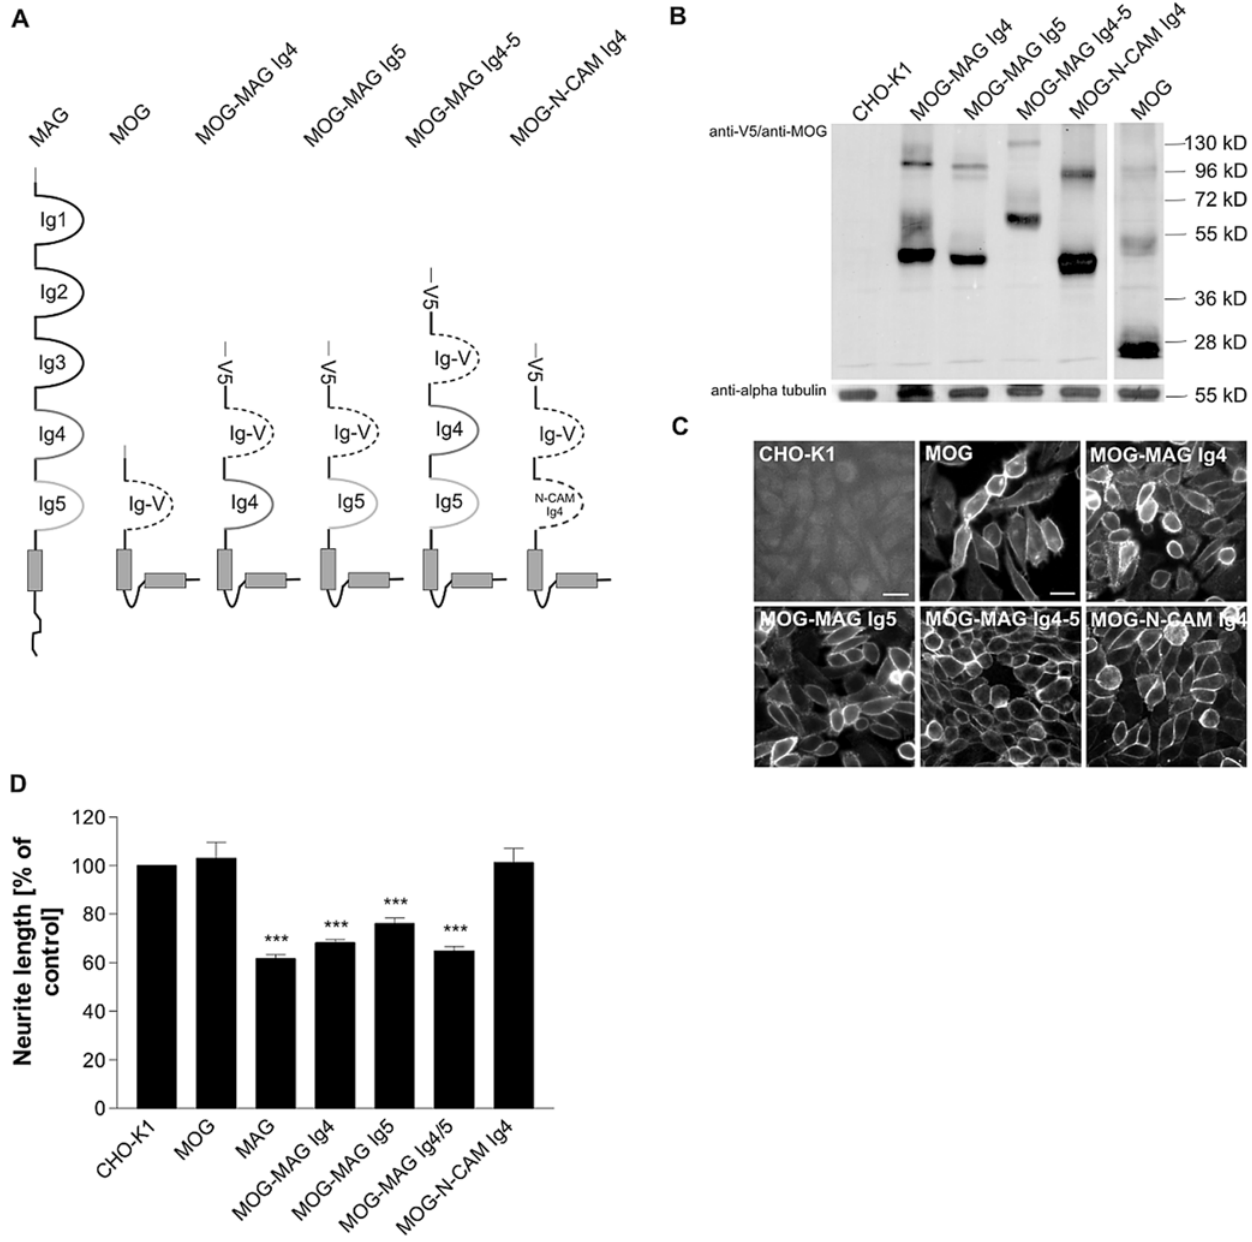
Figure 5. Inhibition of neurite outgrowth by chimeric MOG-MAG molecules. (A) MOG-MAG chimeras, in which either one or two domains of MAG (grey lines) were fused to the MOG Ig-V domain. MOG-N-CAM Ig4 indicates the fusion of the Ig4 domain of the N-CAM molecule to the MOG Ig- V domain. All chimeric proteins have a signal peptide (SP) and carry the cytoplasmic part of MOG along with a V5-tag at their N-terminus. Stable CHO- K1 clones expressing either of these chimeras were generated and characterized by (B) Western Blotting and (C) live anti-V5 immunostaining demonstrating surface expression of each chimera. Scale bar 20 m m. Respective analysis of a MOG expressing CHO-K1 clone was done using an anti- MOG antibody. a -tubulin served as loading control for Western Blots. (D) Analysis of neurite length of wildtype DRG neurons grown on CHO cell monolayers expressing full-length or chimeric forms of MAG. Parental CHO cells served as the control substrate. Graph shows % neurite length on the different substrates 6 SEM. Three to seven separate experiments were examined for each experimental condition, with 50 to 100 neurons measured for each substrate. *** represents P # 0.001 compared to CHO-K1, **p # 0.01, *p # 0.05 one-way analysis of variance with post-hoc Tukey test.